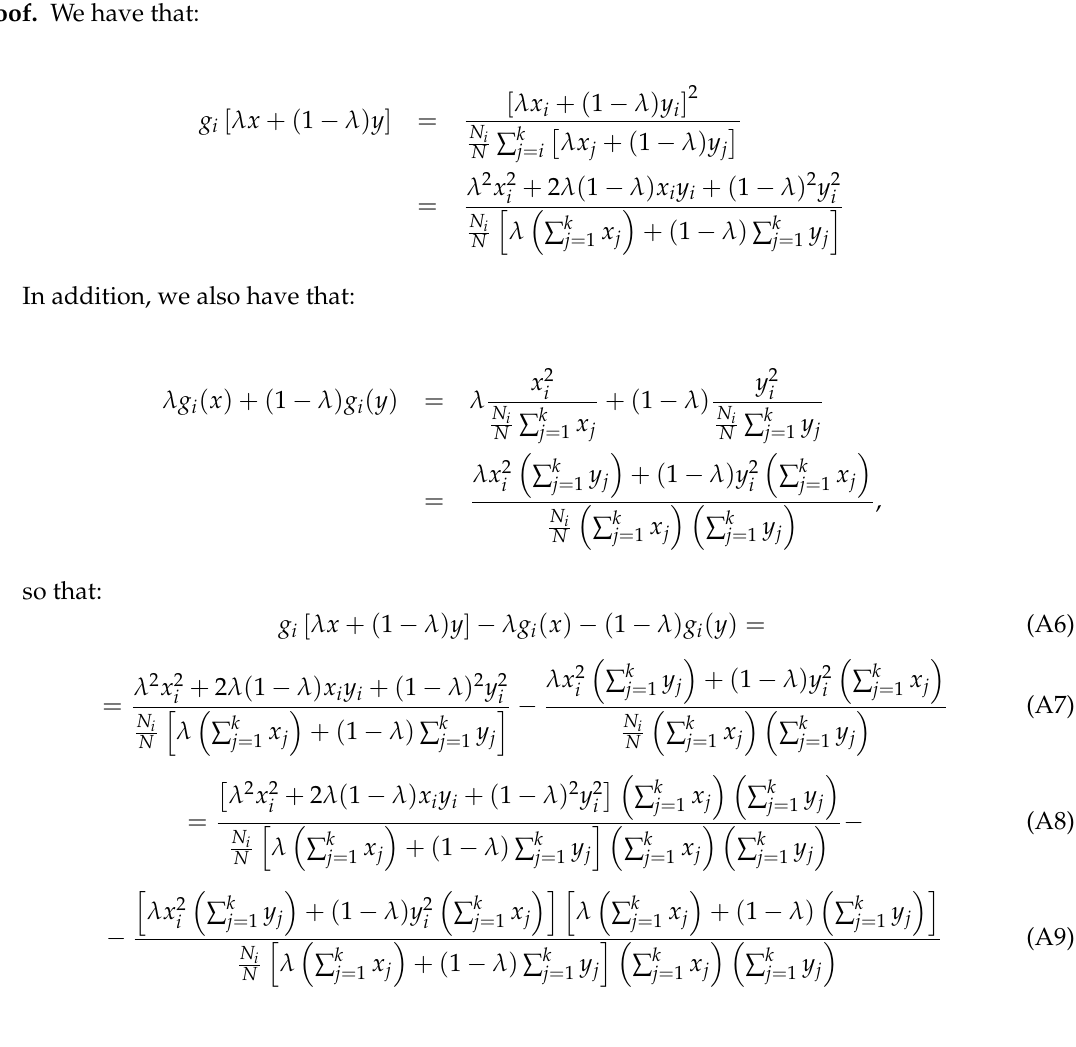
(cid:0) (cid:1) n SUB , . . . , n SUB in R 2 1 k